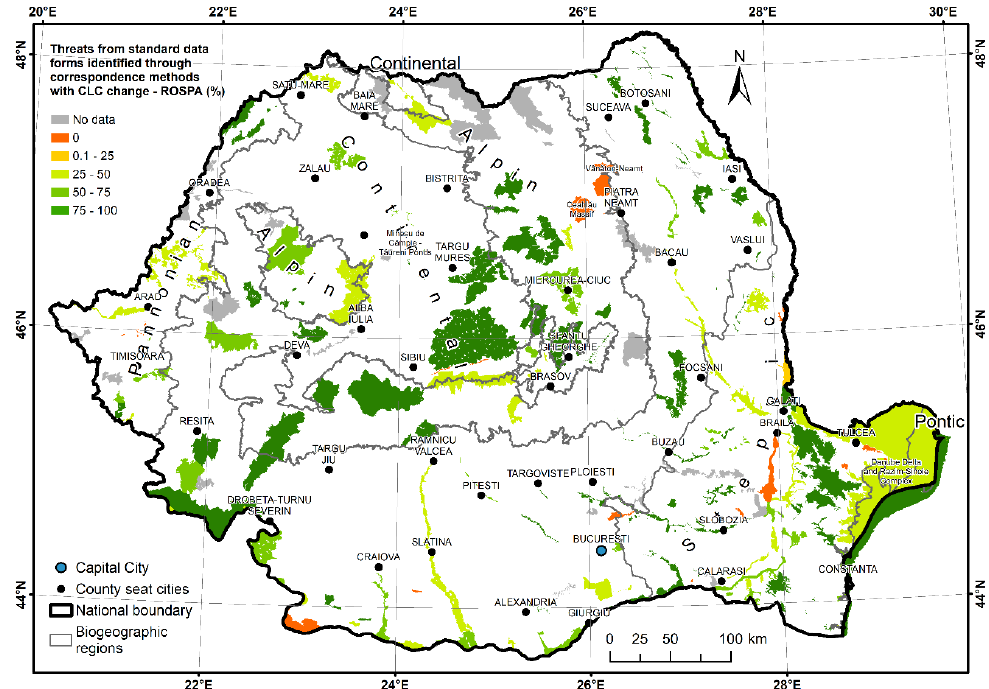
Figure 19. Distribution of threats from standard data forms, identified through correspondence methods with CLC changes (for ROSPA sites).